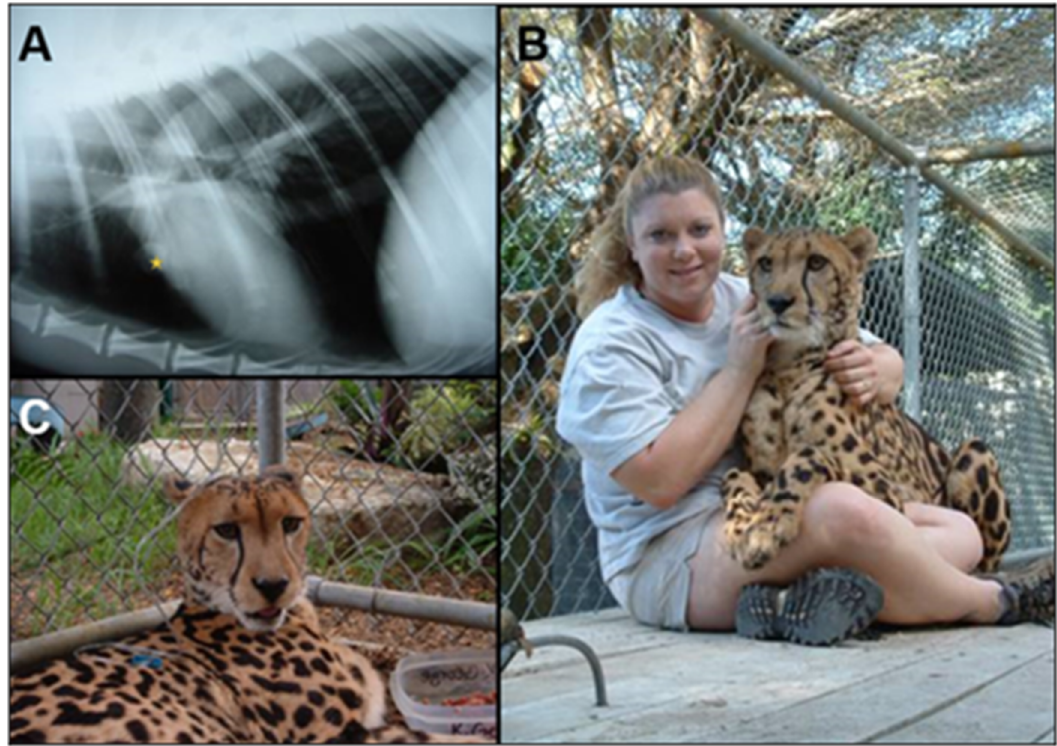
Figure 3. ( A ) Primary pulmonary cryptococcoma (yellow star) in a lateral chest radiograph from a captive cheetah. The “glassy-eyed stare” seen with peripheral blindness is evident in ( C ), which shows the cheetah being given a subcutaneous infusion of amphotericin B. The patient after successful therapy is shown in ( B ), with its carer; note the alert demeanor and normal posture.